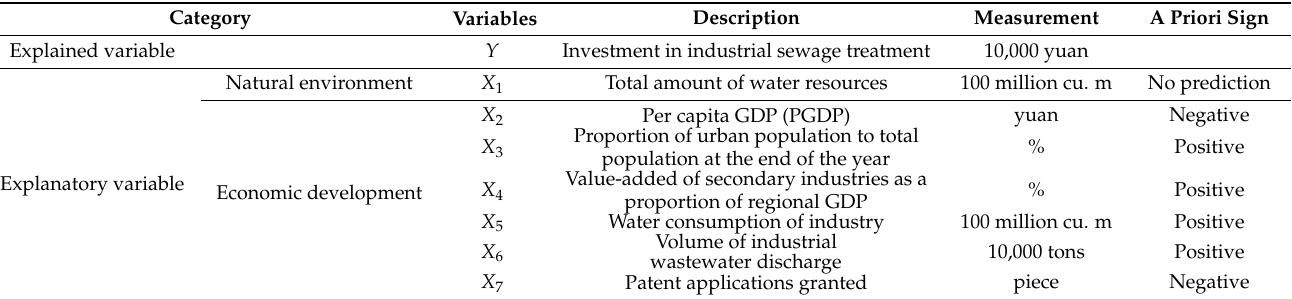
Table 1. Description and measurement of the variables.